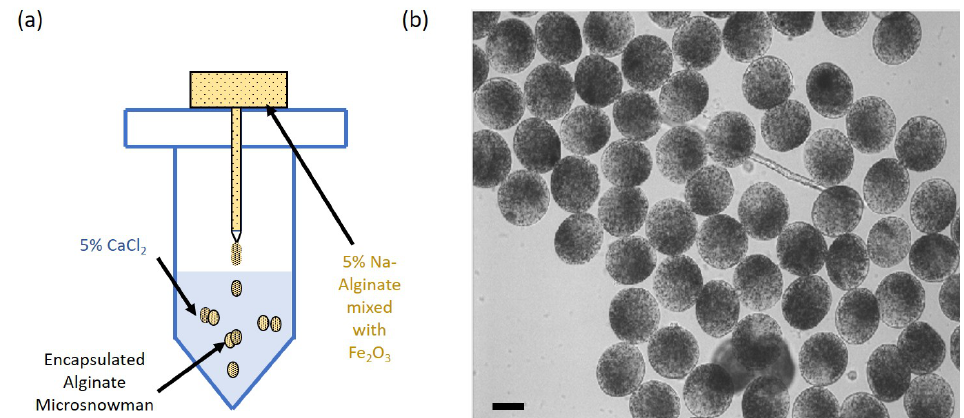
Figure 1. Fabrication of soft alginate particles by a centrifuge-based microfluidic droplet method. ( a ) A droplet microfluidic device was used for the fabrication of the alginate-based microsnowman with encapsulated iron-oxide nano particles. ( b ) The bright field image of the fabricated alginate particles. Single and microsnowman type robots can be seen from the image. The scale bar is set to 100 µ